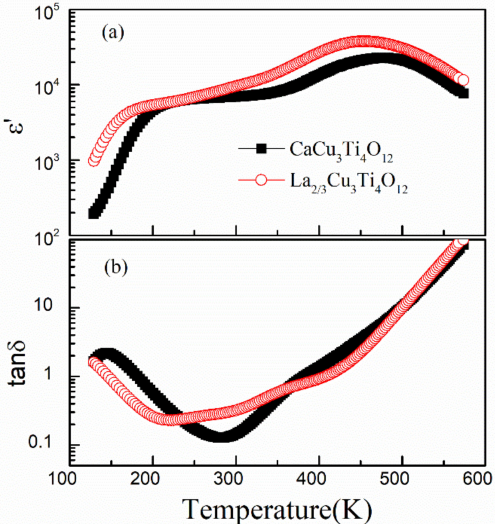
Figure 5. Temperature dependence of the dielectric properties of La 2/3 Cu 3 Ti 4 O 12 and CaCu 3 Ti 4 O 12 ceramics at 100 kHz. ( a ) Dielectric constant and ( b ) dielectric